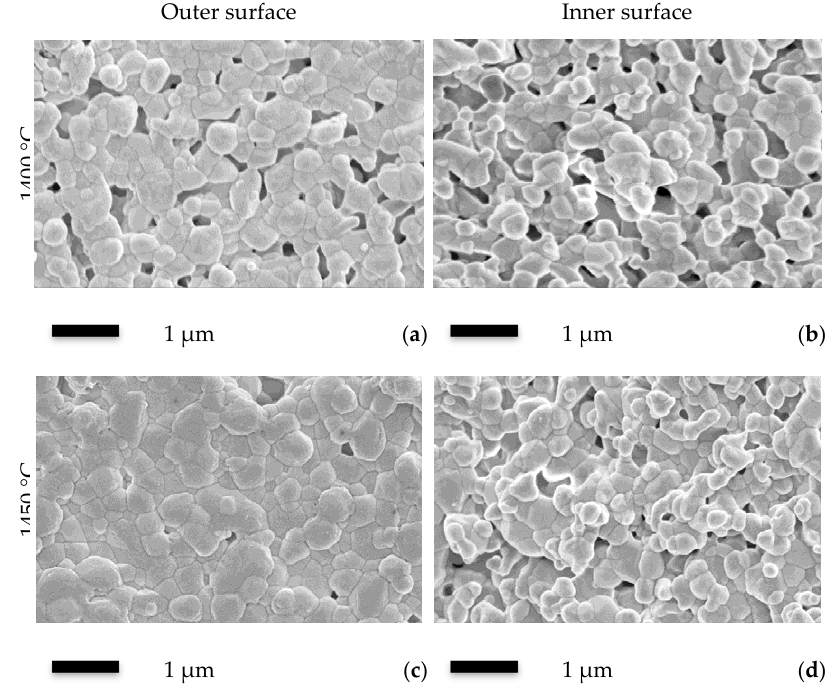
Figure 2. Outer and inner surface SEM images of the Al 2 O 3 ‐ YSZ seven ‐ channel capillary membranes sintered at 1400 and 1450 °C. ( a ) outer surface of the 1400 °C sample; ( b ) inner surface of the 1400 °C sample; ( c ) outer surface of the 1450 °C sample and ( d ) inner surface of the 1400 °C sample. sample; ( c ) outer surface of the 1450 ˝ C sample and ( d ) inner surface of the 1400 ˝ C